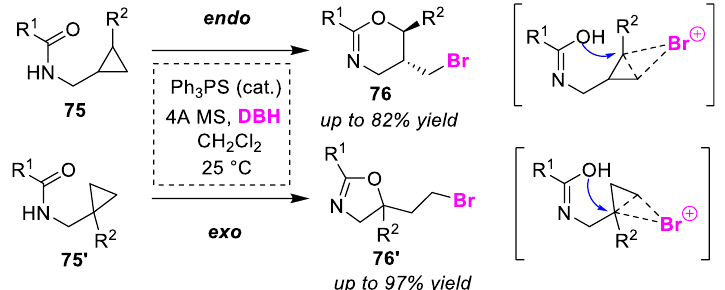
Figure 35. Selective syntheses of oxazines and oxazolines via the chloro-cyclization of olefinic amides ( 73 and 7 3′ ) using (DHQD) 2 PHAL.